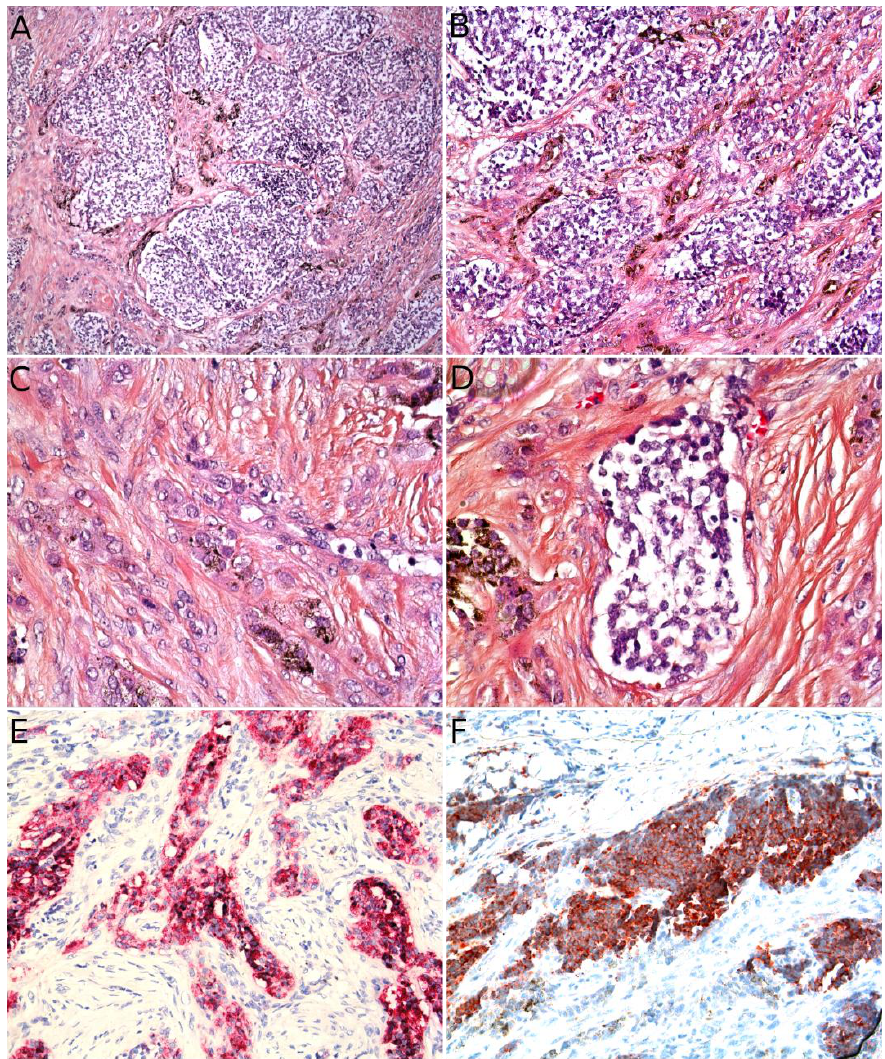
Figure 13. Melanotic neuroectodermal tumor of infancy: ( A ) Nests of small round blue cells sur- rounded by pigmented cells in a fibrous stroma ( × 25); ( B ) biphasic population of neuroblast-like cells and pigmented epithelioid cells ( × 100); ( C ) higher view of the epithelioid cells producing melanin ( × 200); ( D ) higher view of the neuroblast-like cells arranged in a small nest ( × 200); ( E ) HMB45 positivity on the epithelioid cells ( × 100); ( F ) synaptophysin positivity on the small neuroblast-like cells ( ×